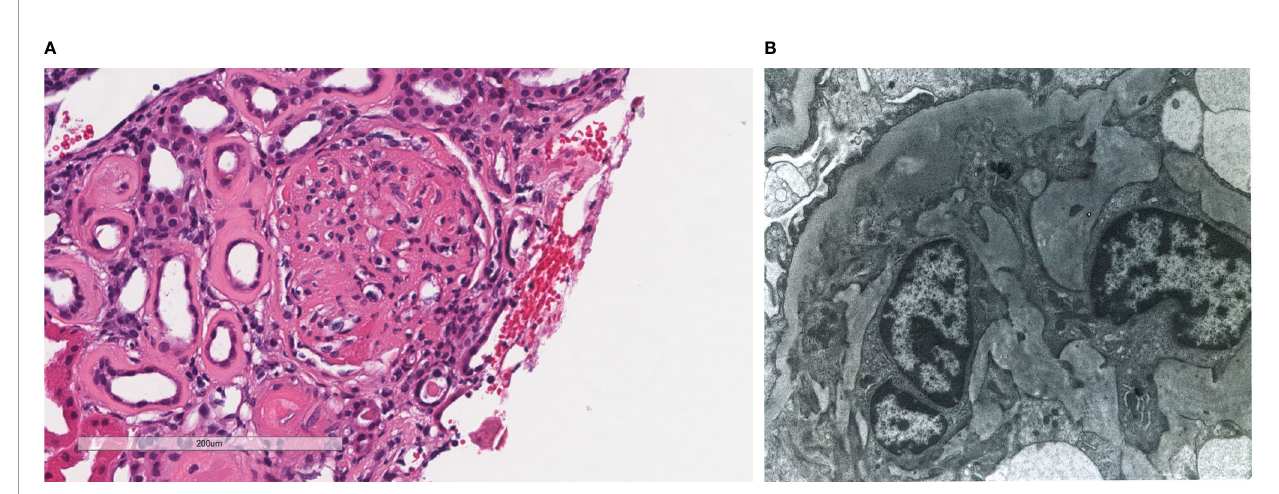
FIGURE 3 | Patient 3. Light microscopy shows an intact glomerulus with prominently thickened capillary walls and segmental mesangial hypercellularity (A) . By electron microscopy, there is prominent widening of the subendothelial space by edema, cell debris, and amorphous proteinaceous deposits. Basement membrane reduplication is complete (B) .